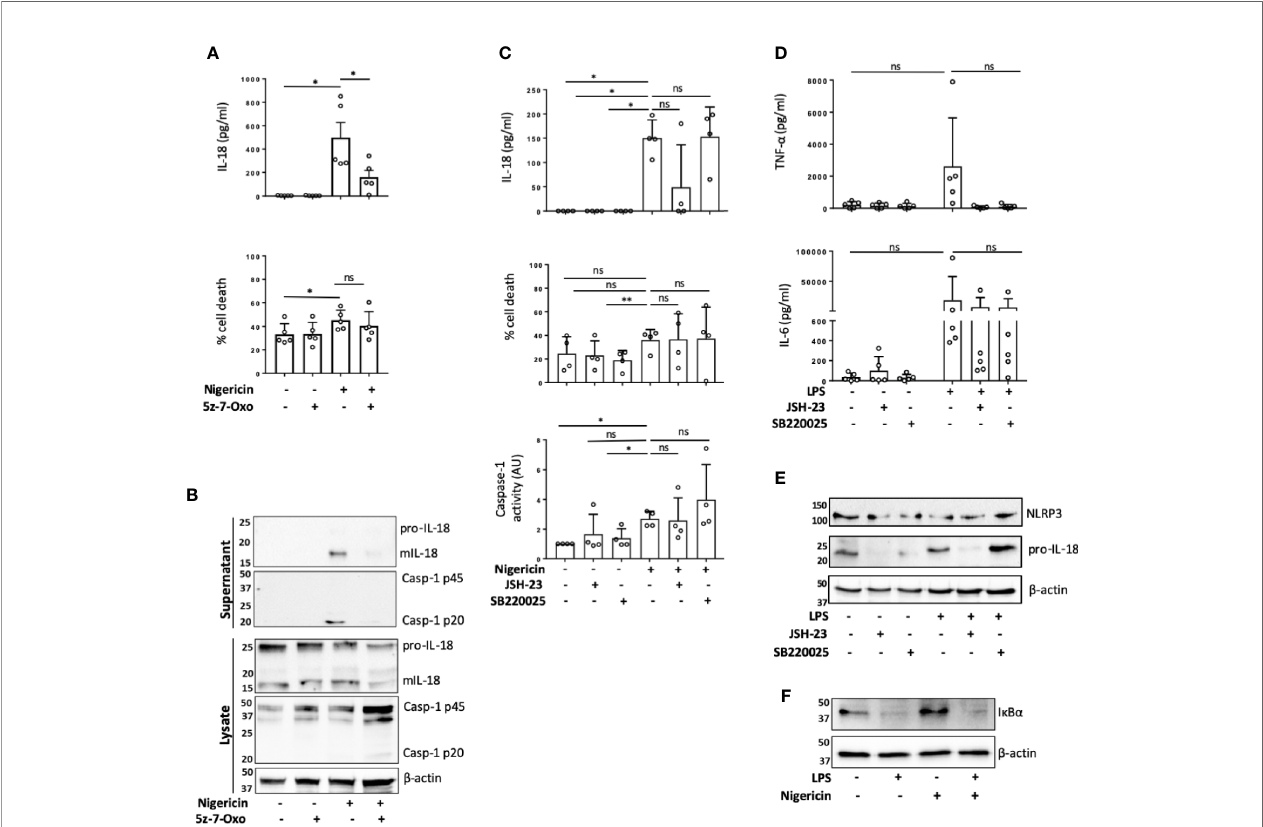
FIGURE 2 | TAK1 and NF- k B differentially contribute to unprimed in fl ammasome activation in human monocytes. (A, B) Primary human monocytes were pre- incubated with 5z-7-Oxozeaenol (0.5 µM) for 15 min prior to treatment with nigericin (10 µM, 45 min). (A) Secreted IL-18 was measured by ELISA and cell death was measured by LDH assay and shown as percentage relative to total cell death. n=5 independent biological replicates (each point represents a different blood donor). Error bars represent mean ± S.D., *P < 0.05 using one-way ANOVA comparing each sample to the nigericin only treated sample. (B) Supernatants and lysates were analyzed for mIL-18 (18 kDa), pro-IL-18 (24 kDa), mCaspase-1 (20 kDa), pro-Caspase-1 (45 kDa), as well as loading control b -actin (42 kDa). Blots are representative of at least 3 independent experiments. (C) Primary human monocytes were left untreated or pre-treated with JSH-23 (40 µM, 13 h) or SB220025